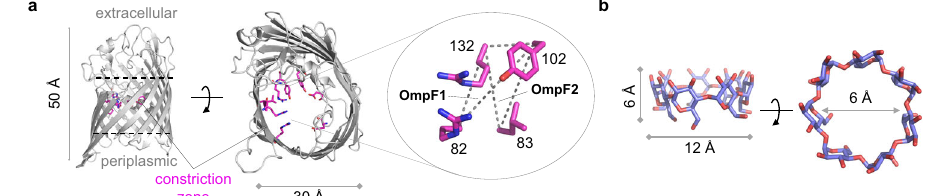
Fig. 1 | OmpF as a versatile scaffold protein. The structural resemblance of a OmpF (PDB 2OMF) and b cyclodextrin (CSD TEZZUV). Only one protomer of trimeric OmpF is shown for clarity. The horizontal dotted lines in a represent the